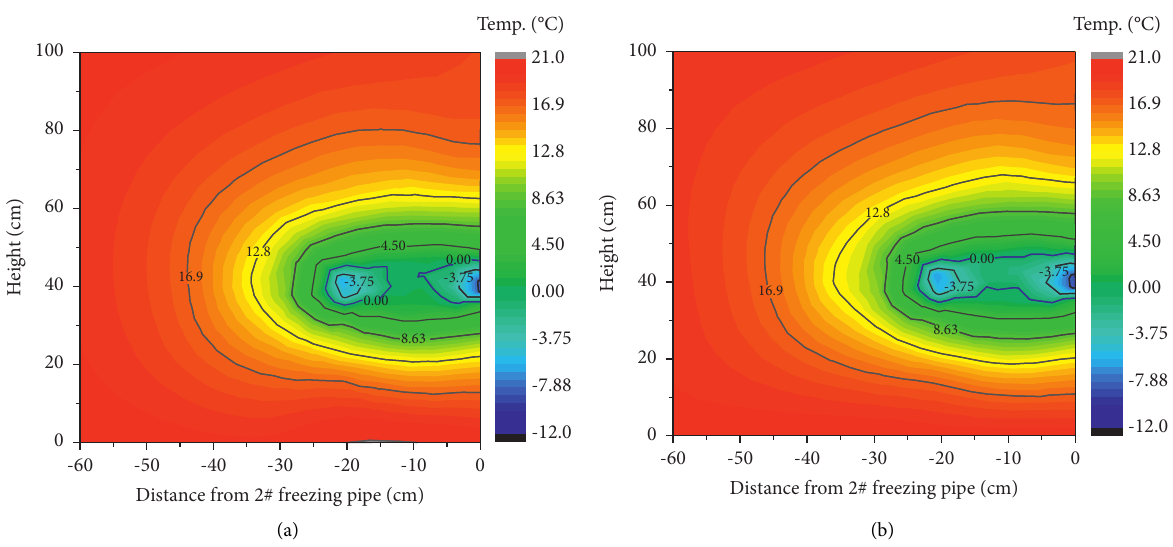
Figure 10: Temperature fields of gravel formation at a seepage flow rate of 2.5 m/d. (a) Freezing duration of 8 h. (b) Closure time of frozen wall 16.8